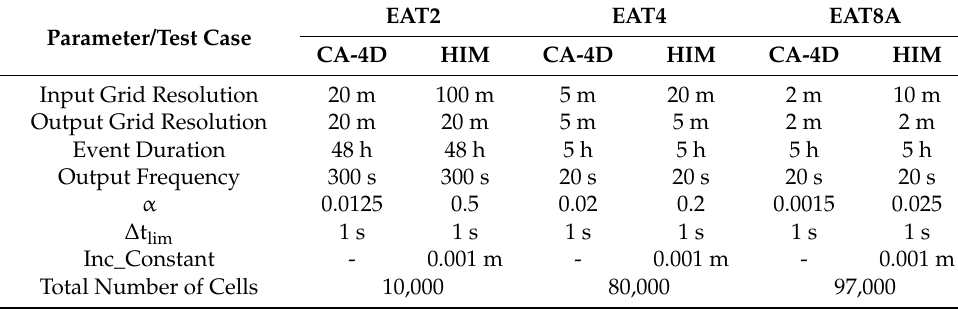
Table 1. Parameters used in CA-4D and the HIM for the EA benchmark test cases.